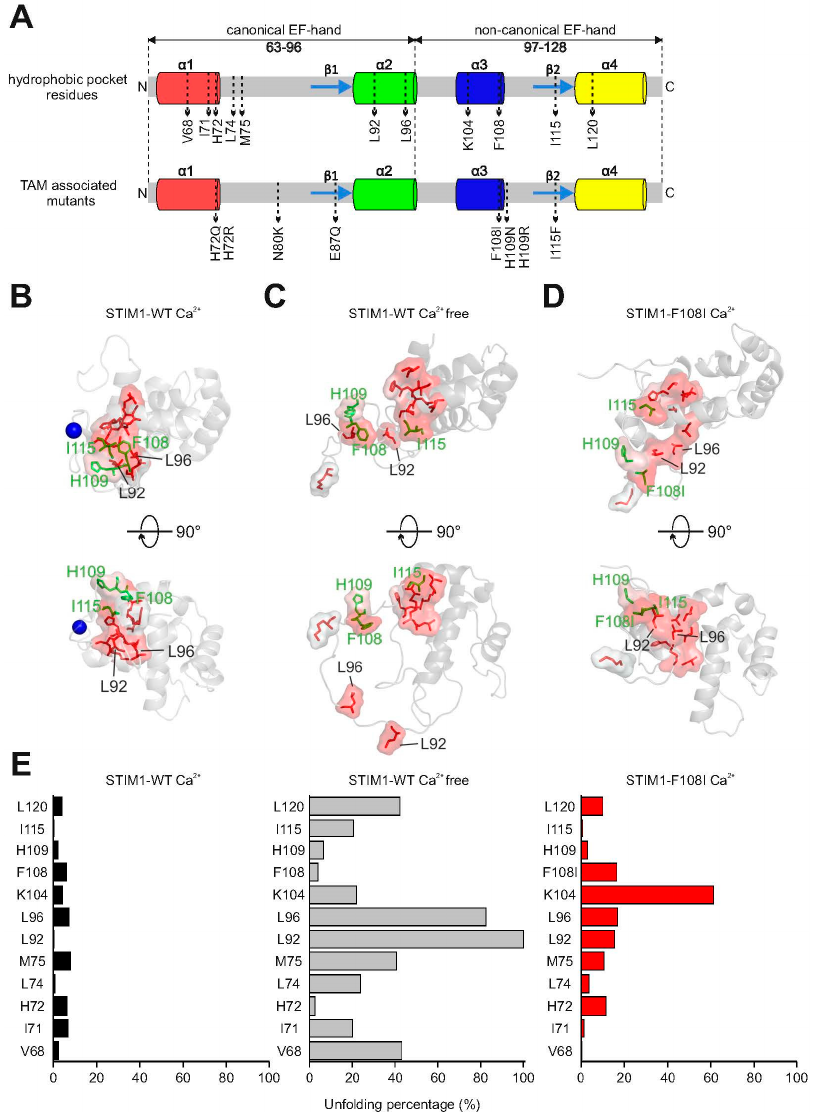
Figure 2. Unfolding of the hydrophobic pocket of STIM1 upon Ca 2 + depletion. ( A ) Schematic representation of canonical and non-canonical EF-hand structures showing α -helices as cylinders and β -sheets as arrows. In the upper panel, specific amino acids that form the hydrophobic pocket (as described in [11]) are highlighted. The lower panel shows disease-related mutations that are located in the canonical and non-canonical EF-hand domains [35,36]. ( B–D ) Hydrophobic pocket residues from panel ( A ) are shown both as red spheres and as stick models in two orientations, ( B ) in the Ca 2+ - bound resting state of STIM1 based on NMR results and a bound Ca 2+ ion (shown as blue sphere) [11], ( C ) upon Ca 2+ depletion or ( D ) in a STIM1-F108I mutant (from MD simulations [17]). In addition, hydrophobic residues of the non-canonical EF-hand are shown as green sticks. ( E ) Relative proportion of unfolding (in %) for residues of the canonical and non-canonical EF-hands that contribute to the